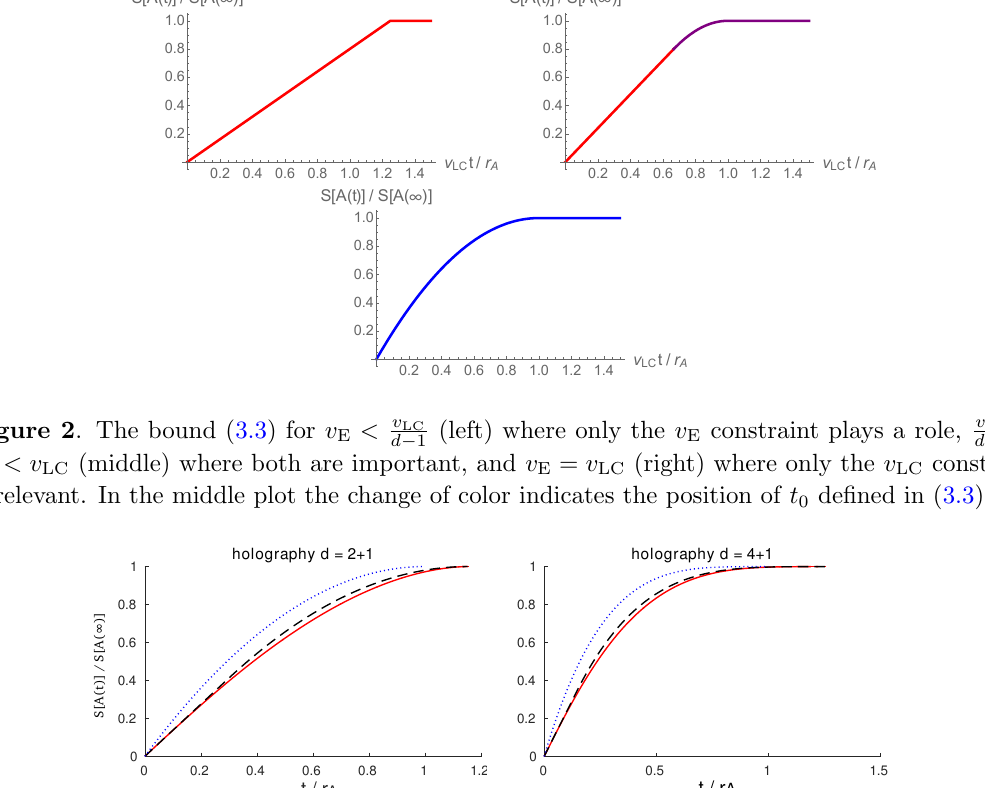
Figure 3 . We plot S [ A ( t )] until saturation for a large sphere. Black/dashed is our upper bound using the speeds (2.6), blue/dotted is the bound from relativistic causality [16] and red/solid is the holographic computation [17]. The dashed lines should be understood as one-parameter ( v E ) (cid:12)ts, because v LC is determined by an independent calculation based on commutators (or equivalently, out-of-time order correlation